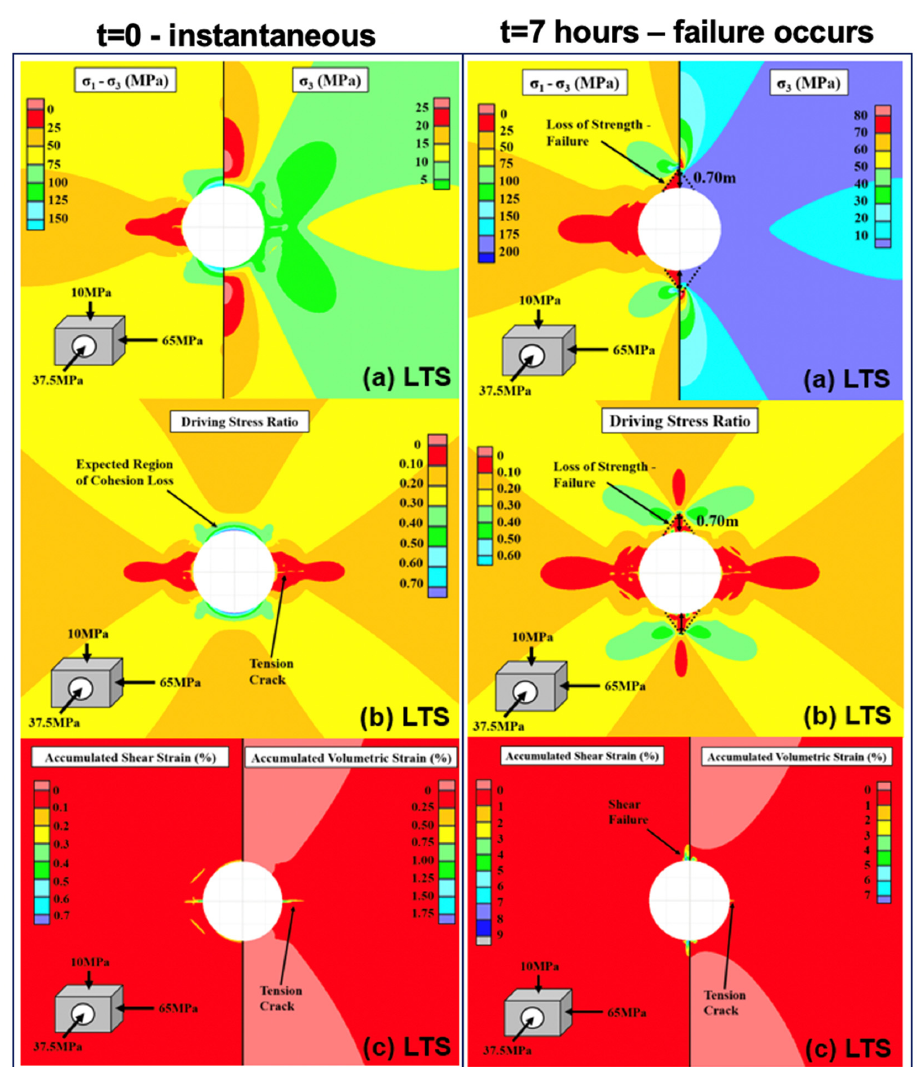
Figure 14. Instantaneous using plasticity. Left: ( a ) in–situ stresses, ( b ) driving stress ratio, and ( c ) shear and volumetric strains and after 7 h (failure time) using the LTS model. Right: ( a ) in-situ stresses, ( b ) driving stress ratio with depth of failure, and ( c ) shear and volumetric strains for the LTS model.